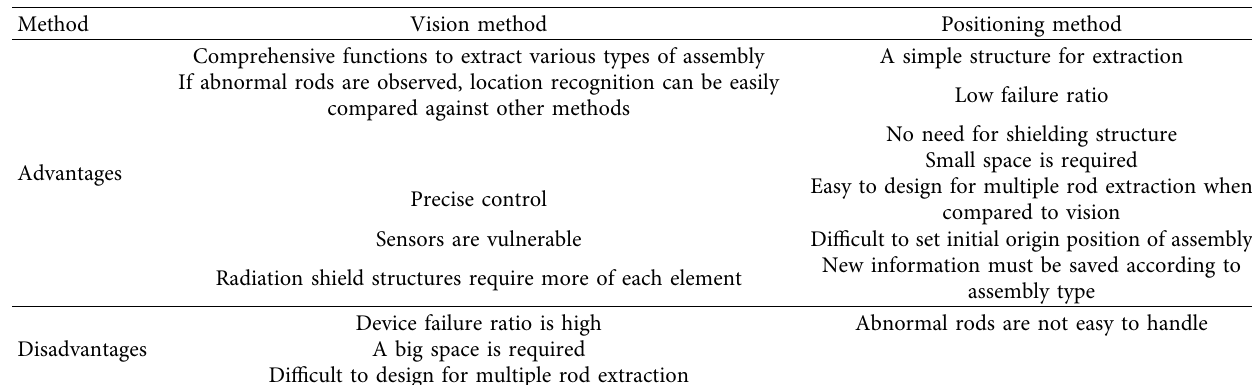
Figure 10: Extractor modules configuration diagram. Table 2: Comparison of vision and positioning methods for rod